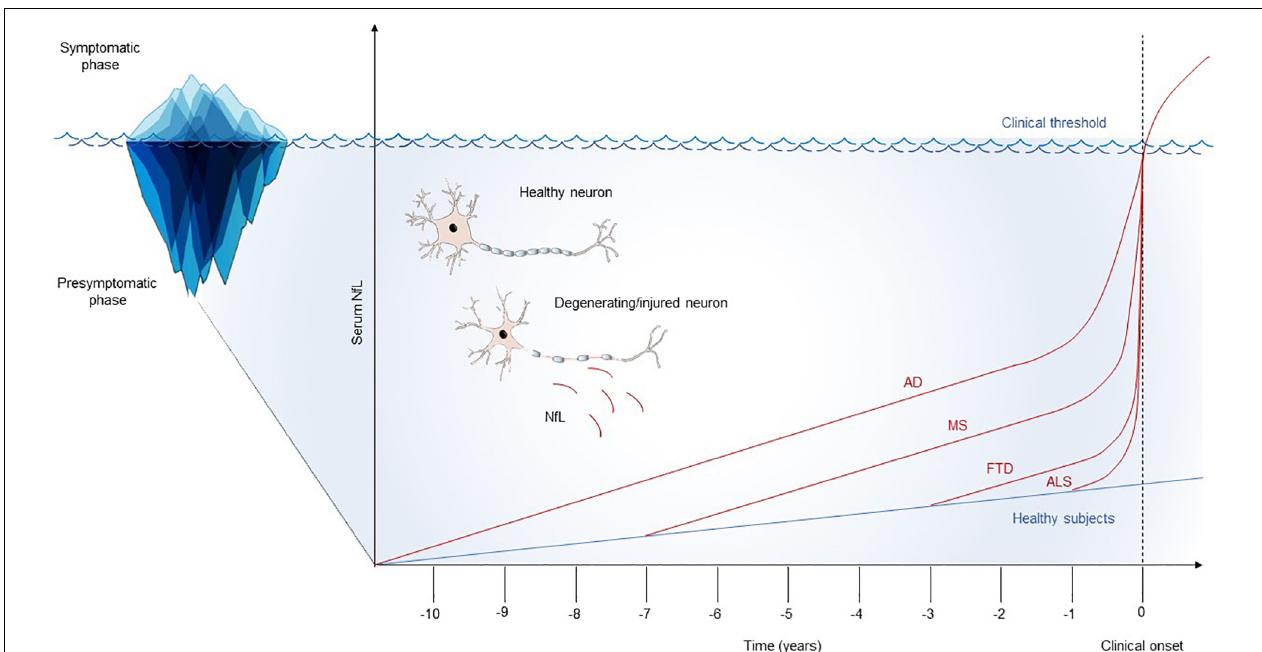
FIGURE 1 | Schematic model of the longitudinal trajectories of serum NfL. Serum NfL studies highlight possible differences in the natural history of neurological diseases, with variable durations of the presymptomatic phase, probably reflecting the rate and overall burden of the underlying neurodegenerative processes. For all the diseases, an acceleration on serum NfL raise in proximity with the appearance of the first clinical manifestations has been documented. This longitudinal trend could suggest a flare in the pathophysiology of neurological diseases at the border zone between preclinical and clinical phases. AD, Alzheimer’s disease; ALS, amyotrophic lateral sclerosis; FTD, frontotemporal dementia; MS, multiple sclerosis; NfL, neurofilament light